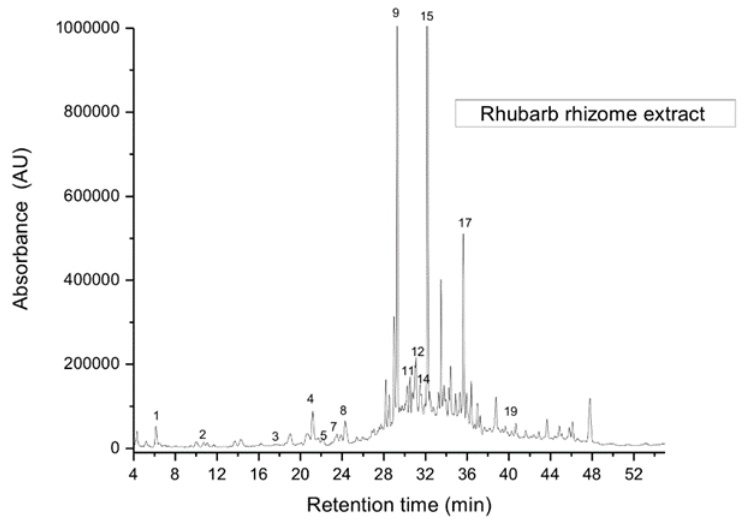
Figure 3. Chromatogram of identified polyphenolic compounds detected in extracts of rhubarb rhizome. Peak identification, see Table 4.